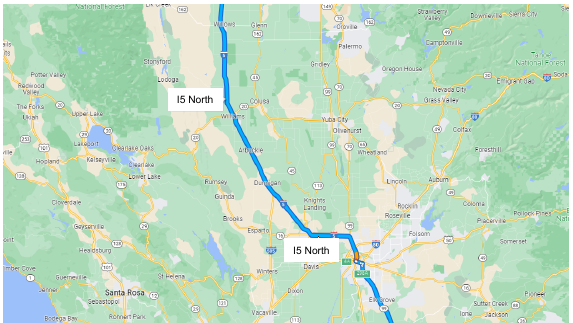
Figure 4. The post-mile ranges from 495.73 to 621.42 located at the freeway